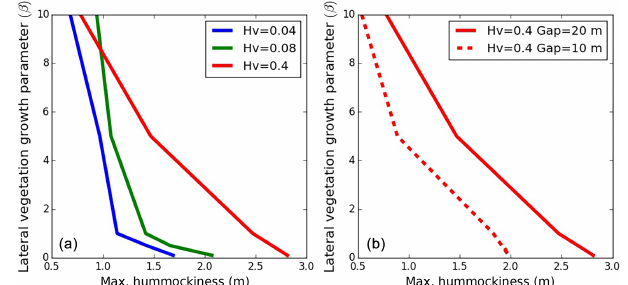
Figure 5. The impact of changes in the vertical vegetation growth parameter ( H v ) and lateral vegetation growth parameter ( β ) on (a) the time of maximum hummockiness and (b) the time when coalescing